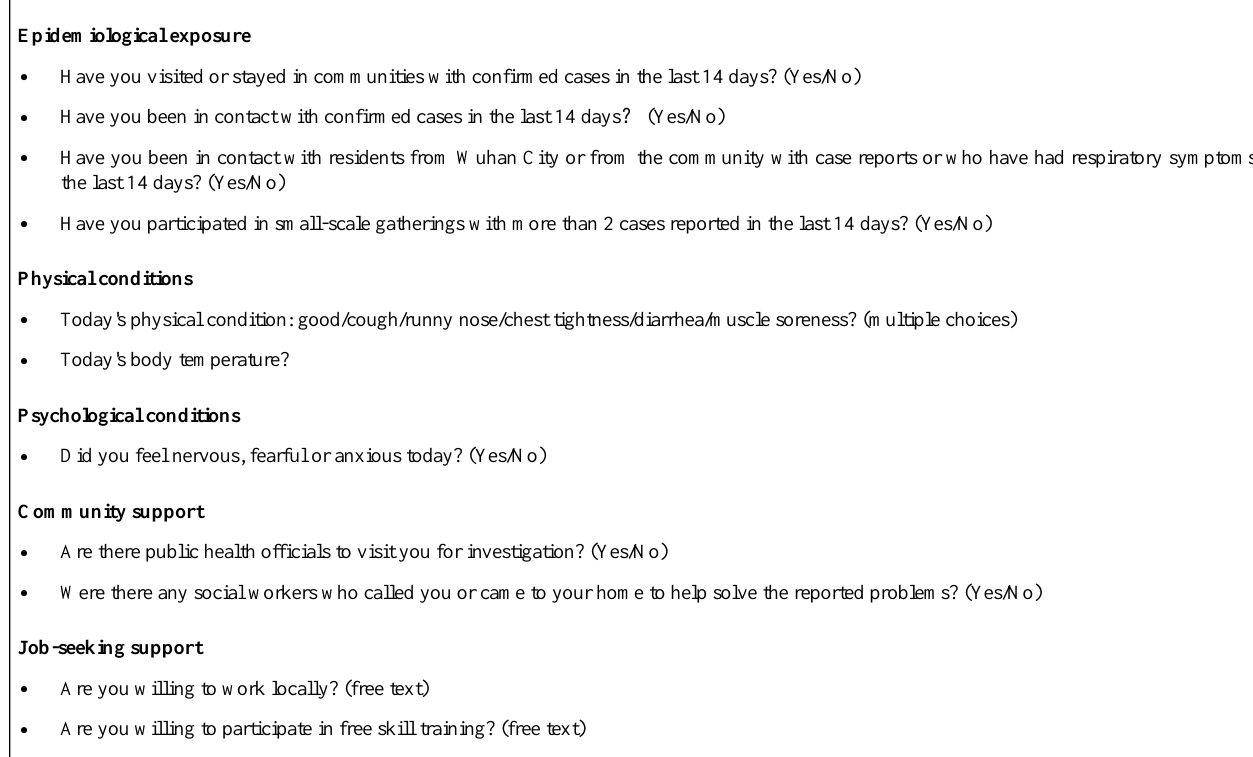
indicated by the concentration of the patients on the map (Figure 2), illustrated high risk for local outbreaks and would then trigger home visits by social workers